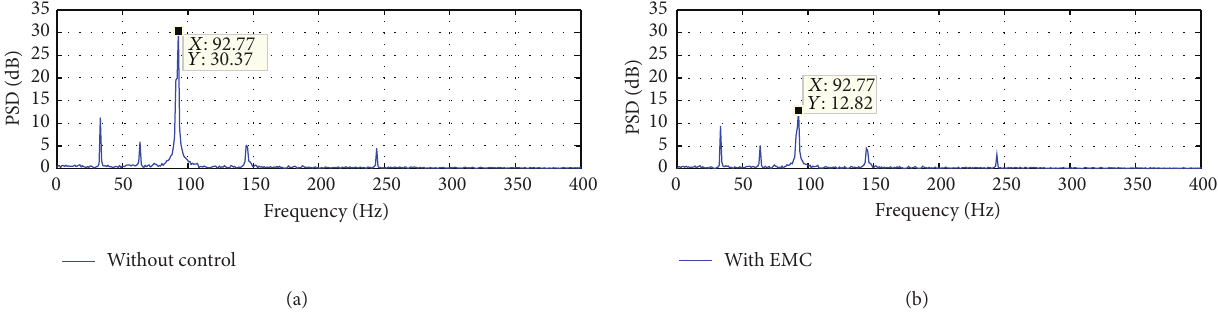
Figure 11: FFT of the first vibration mode of the first link.